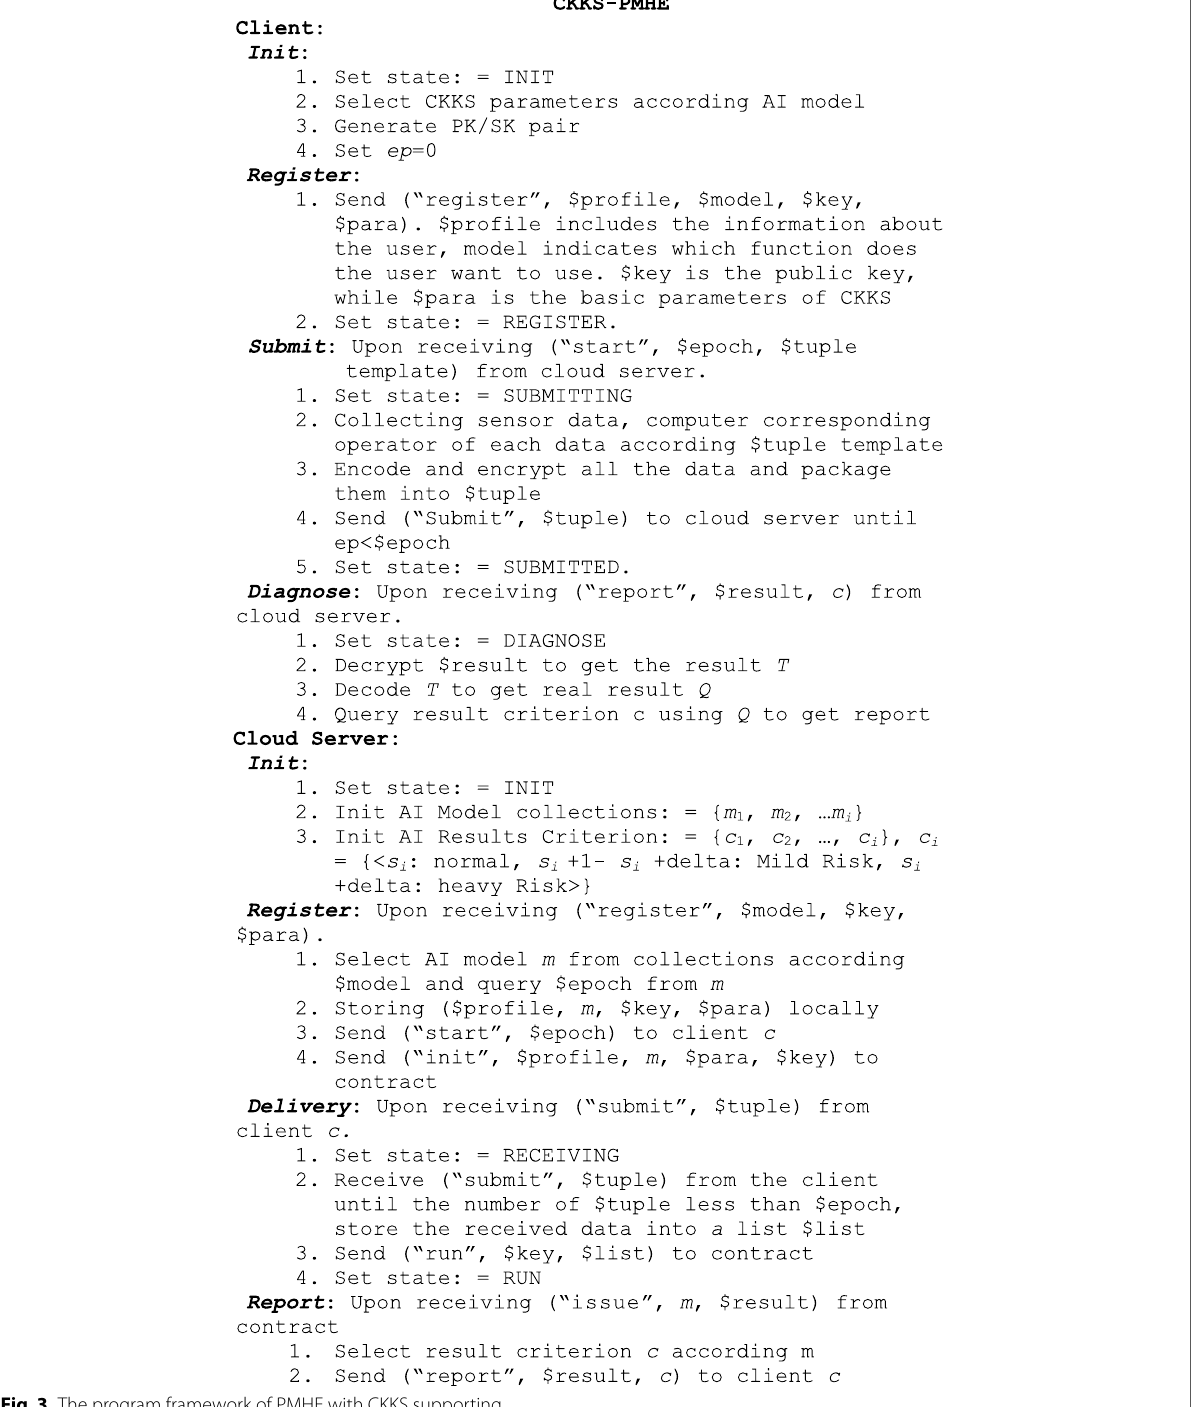
Fig. 3 The program framework of PMHE with CKKS